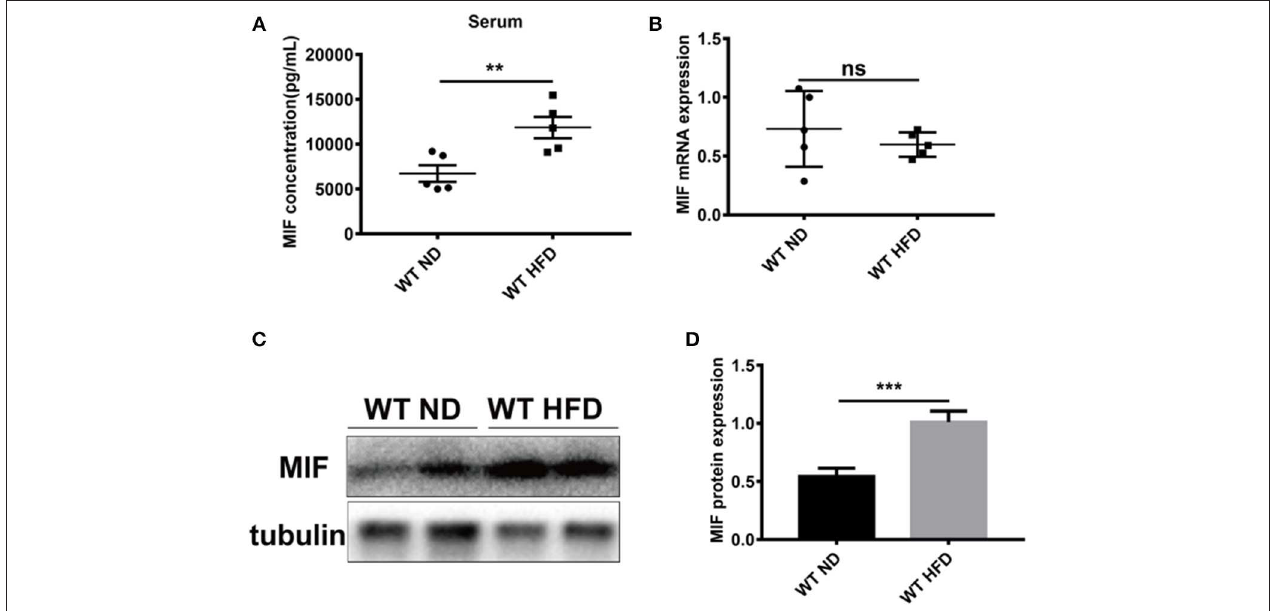
FIGURE 1 | Serum MIF and the expression of MIF in adipose tissue were increased in HFD-treated mice. (A) The serum MIF level was determined with MIF ELISA kit in HFD-treated WT mice and ND-treated WT mice. (B) The expression of MIF by real-time PCR analysis in adipose tissue from HFD-treated WT mice and ND-treated WT mice. (C) The images of MIF protein by Western blot analysis in adipose tissue from HFD-treated WT mice and ND-treated WT mice. (D) Quantitative analysis of MIF protein level from western blot bands. Data are shown as mean ± SEM, ** p < 0.01 and *** p < 0.001, n = 3–5 per